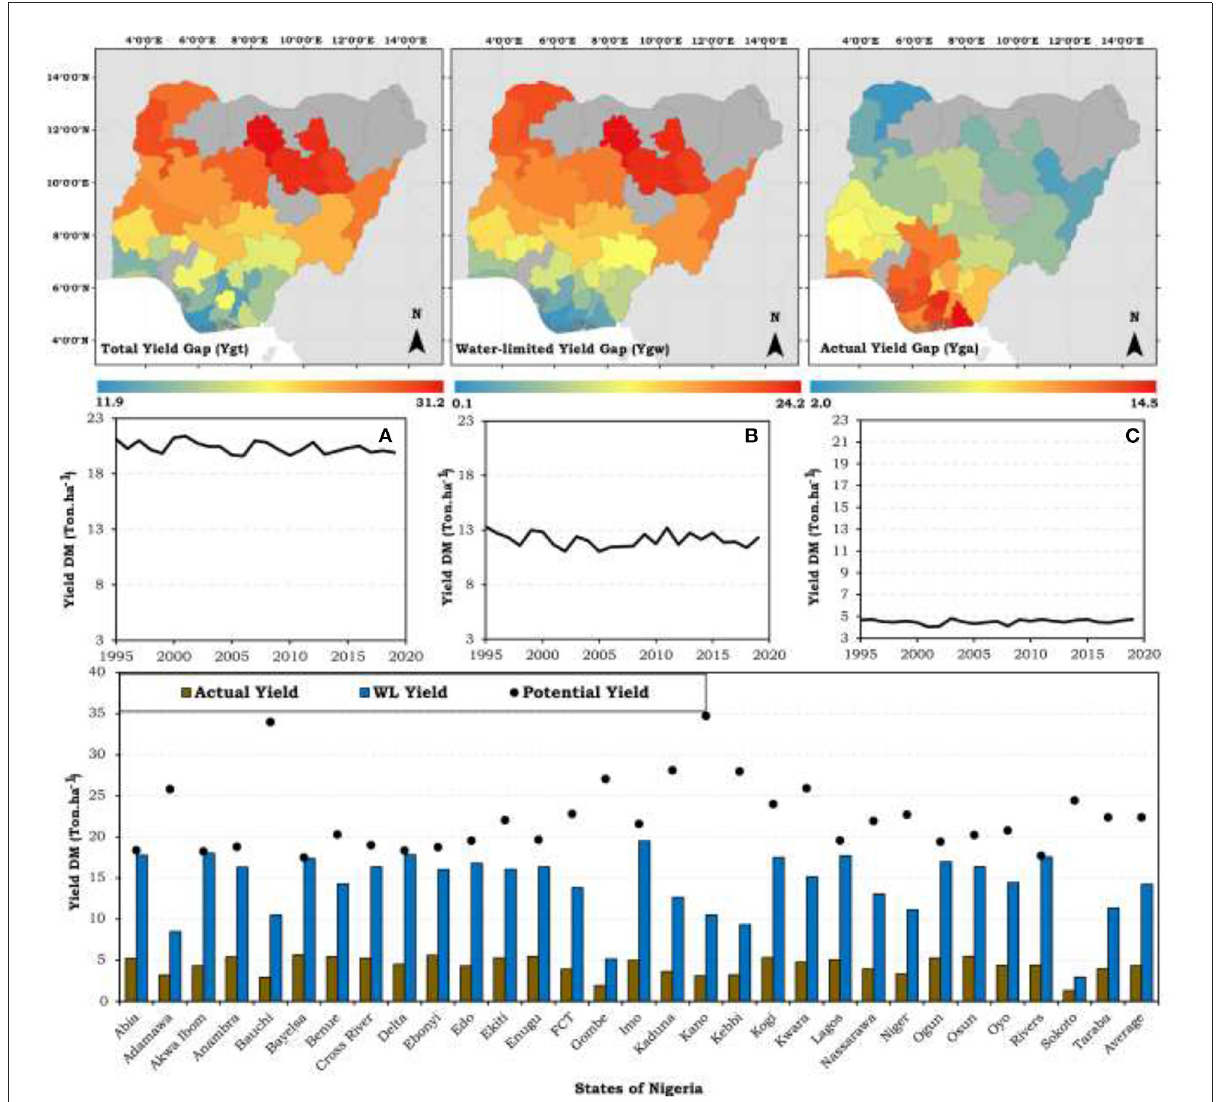
FIGURE5 Spatial analysis of total yield gap, water-limited yield gap, and actual yield gap across the 30 states from 1995 to 2019. (A–C) pertain to the temporal variability in simulated cassava yield under potential, water-limited, and actual conditions, respectively. The Fig at the bottom (last row) illustrates the simulated value average over 20 years of actual yield (Nutrient and water-limited), water-limited (WL) yield, and the potential yield across the 30 states of